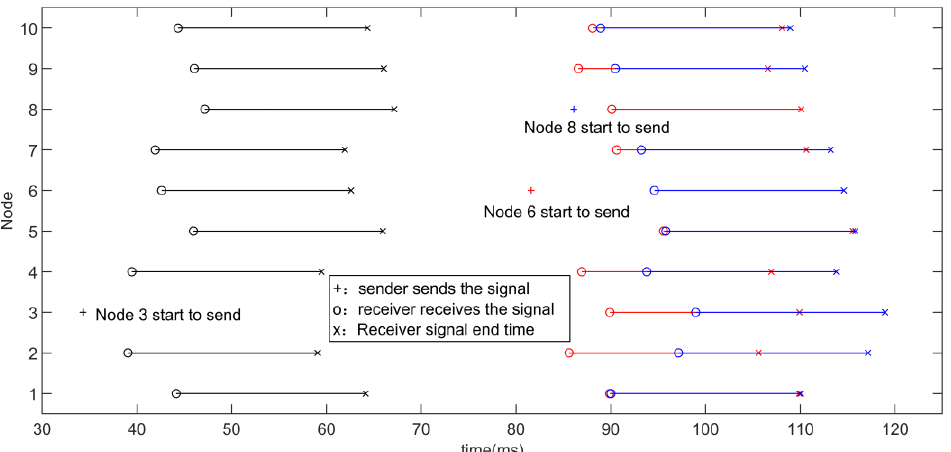
Figure 17. Simulation of Multi-Node Near Ultrasonic Ranging Conflict. Each row represents the time axis of each node, “ + ” indicates the moment when the sender sends the signal, “ o ” indicates the moment when the receiver receives the signal, and “ x ” indicates the end moment of the signal received by the receiver. Node 6 decides to send a signal at the red “ + ” moment, and the signal arrives at all other nodes in turn. The arrival time is marked with a red “ o ” in other rows (corresponding to all other nodes) and ends at a red “x”. Due to the long propagation delay, when the signal sent by node 6 has not yet reached node 8, node 8 mistakenly thinks that the channel is idle and is ready to send a signal, so it sends a signal at the blue “ + ” moment, and the signal sent by node 8 reaches other. For all nodes, the time of arrival is marked with a blue “ o ” in other rows (corresponding to all other nodes) and ends at a blue “ x ” . In this process, due to the long propagation delay, node 8 mistakenly thinks that the channel is idle, so it collides with the signal sent by node 6.